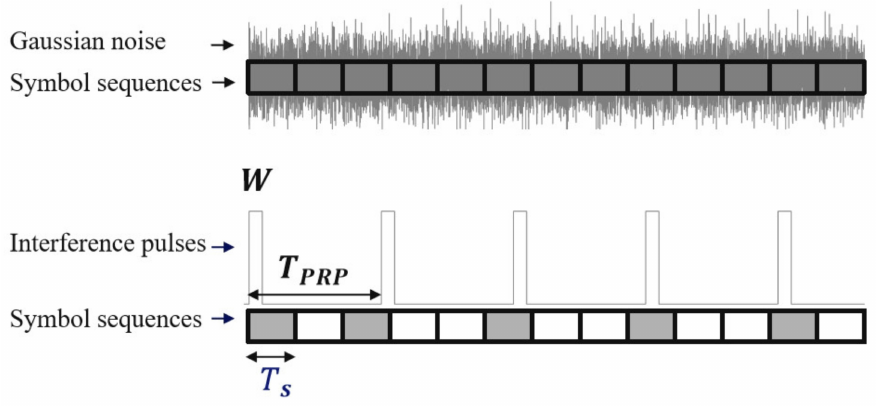
Figure 6. Noise interference and pulse interference contrast